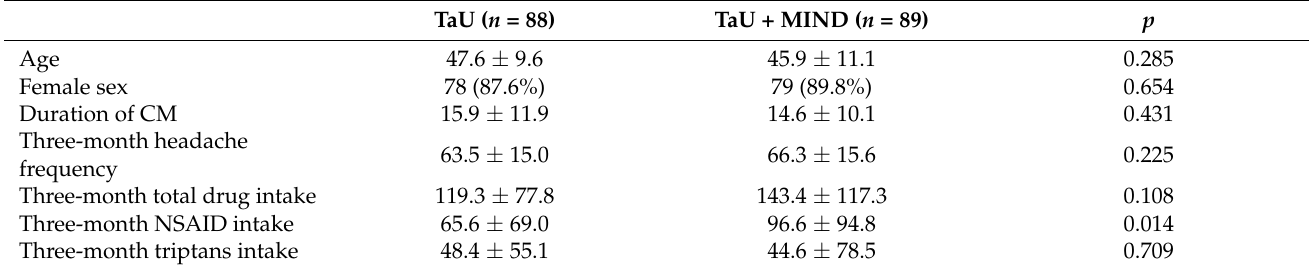
Table 1. Baseline differences between the two groups.